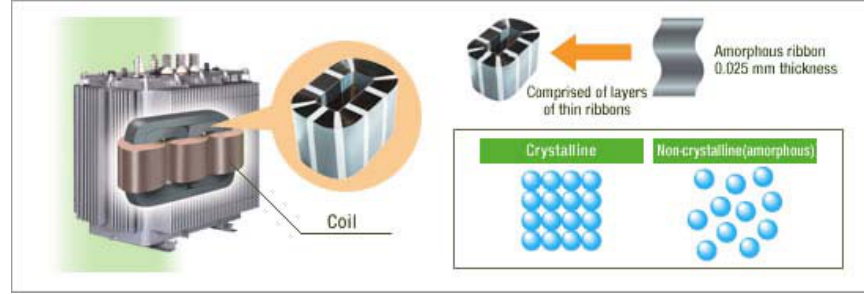
Figure 4. “Amorphous core transformer”. Source: Amorphous Core